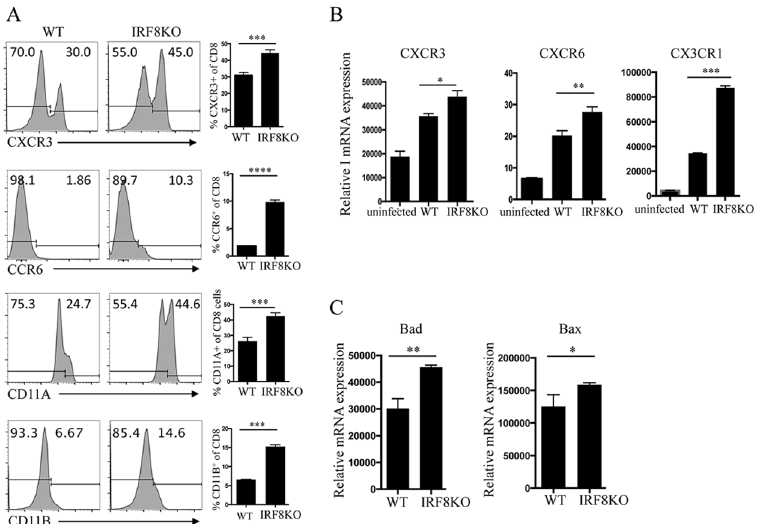
Fig 4. IRF8 regulates expression of chemokine receptors and integrins in CD8 + T cells. (A) IRF8KO and WT mice were infected with HSV-1 and on day 8 p.i. We isolated CD8 + T cells from the spleen and analyzed their immunophenotype by flow cytometry. Numbers on the histograms indicate percentage of CD8 + T cells expressing CXCR3, CCR6, CD11a or CD11b. (B,C) RNA isolated from sorted CD8 + T cells were analyzed by qPCR for the expression of (B) chemokine receptors, (C) pro-apoptotic molecules. Data represent at least 3 independent